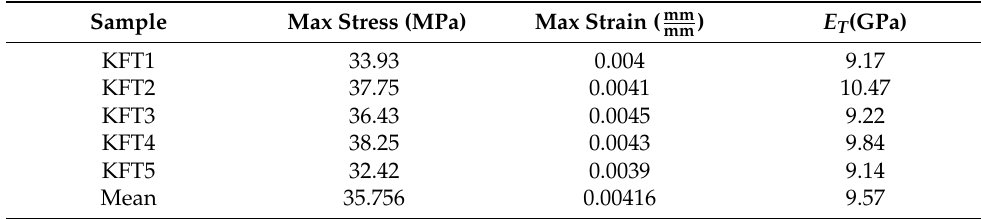
Table 3. Tensile test results of Onyx™– Kevlar ® 3D-printed composites.